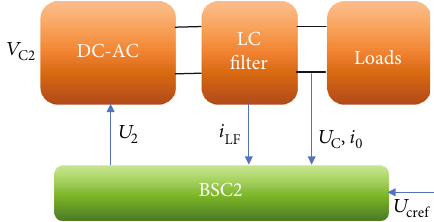
Figure 6: Block diagram of the second stage (H-bridge